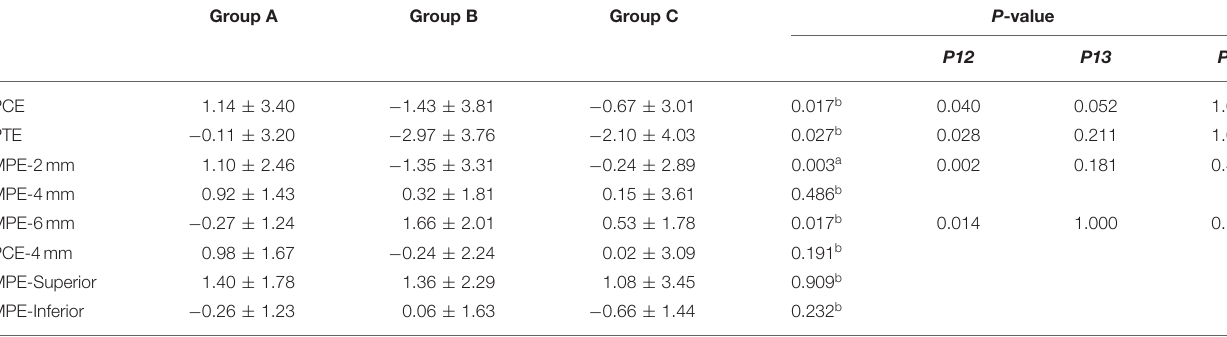
TABLE 3 | Changes of posterior corneal elevation after 3 years of SMILE in different groups. Group A Group B Group C P